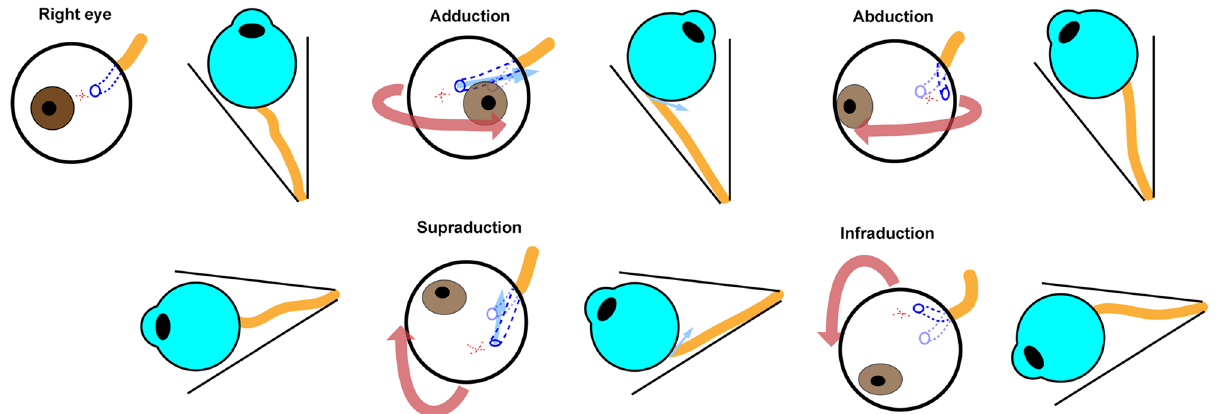
Figure 9. Tethering effect by optic nerve sheath during adduction, abduction, supraduction, and infraduction of right eye. During adduction, the anterior part of the eyeball is rotated nasally, which results in the